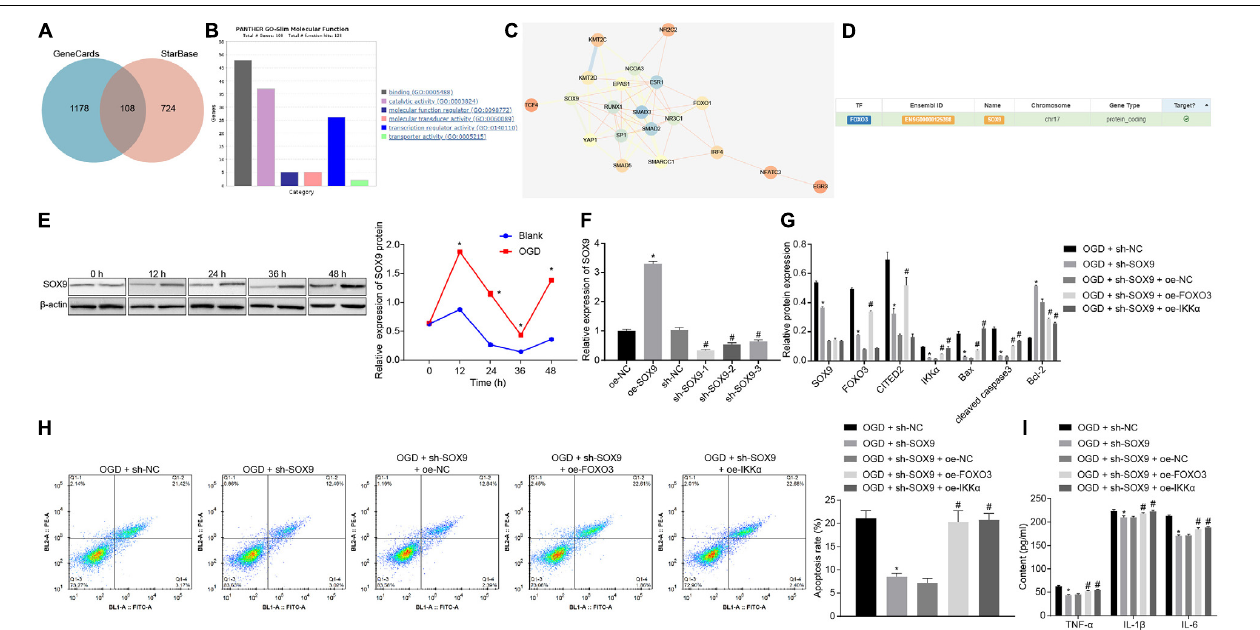
FIGURE 5 | SOX9 enhances OGD-induced neuronal cell apoptosis via upregulating the FOXO3/CITED2/IKK α axis. (A) Venn plot of the intersection of the regulatory gene of FOXO3 in GeneCards predicted on the RNAInter website. (B) GO enrichment analysis of genes through the Panther website. (C) The network diagram of interaction relationships among 26 genes analyzed on the STRING website, with the color of circles from blue to orange referring to degree and the line in the middle of circles indicating the co-expression relationship between genes. (D) The binding relationship between FOXO3 and SOX9 identified on the hTFtarget website. (E) The protein expression of SOX9 normalized to β -actin at different time points after OGD treatment determined by western blot analysis. (F) The mRNA expression of SOX9 in neuronal cells determined by RT-qPCR after silencing of SOX9. (G) Western blot analysis for measurement of expression of apoptosis-related proteins (cleaved caspase 3, Bax, Bcl-2, and caspase 3 expression) normalized to β -actin in neurons. (H) The apoptosis of neurons examined by flow cytometry. (I) Expression of inflammatory cytokine (TNF- α , IL-1 β , and IL-6) in the cell supernatant assessed by ELISA. In panel (E) , * p < 0.05 vs. the blank group (neuronal cells without OGD treatment). In panel (F) , * p < 0.05 vs. neuronal cells treated with oe-NC; # p < 0.05 vs. neuronal cells treated with sh-NC. In panels (G – I) , * p < 0.05 vs. OGD-exposed neuronal cells treated with sh-NC; # p < 0.05 vs. OGD-exposed neuronal cells treated with sh-SOX9 and oe-NC. Measurement data were expressed as mean ± standard deviation. Comparisons among multiple groups were conducted by one-way ANOVA with Tukey’s post hoc test. Data at different time points were compared by repeated-measures ANOVA, followed by the Bonferroni’s post hoc test. The experiment was repeated three times